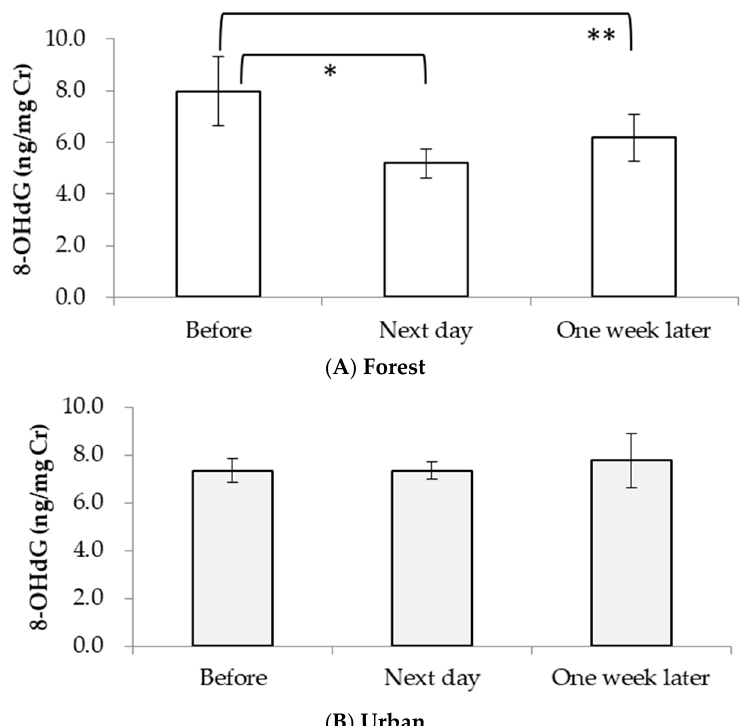
Figure 3. ( A ) Urinary 8 ‐ OHdG levels before, the next day and one week after the forest or urban walk (* p < 0.1: pre ‐ forest walk vs. the day after the forest walk; ** p < 0.05: pre ‐ forest walk vs. one week after the forest walk). ( B ) Urinary 8 ‐ OHdG levels before, the next day and one week after the urban walk.